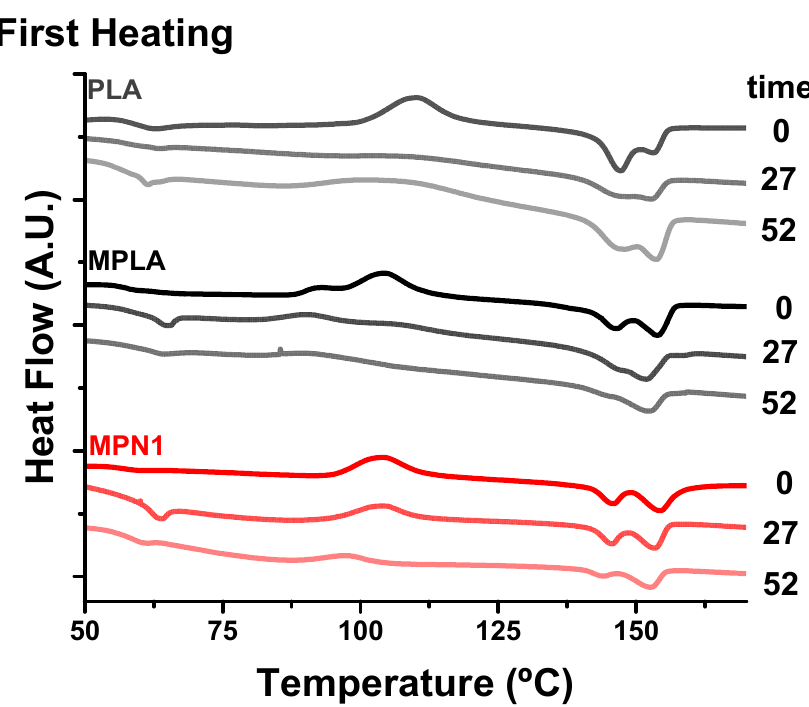
Figure 7. Changes in DSC curves for MPLA biocomposites during biodegradation in soil. The loss of color in the lines corresponds to the increase in biodegradation time. Table 7. DSC data corresponding to the first heating scan for MPLA bicomposites during biodegradation in soil.